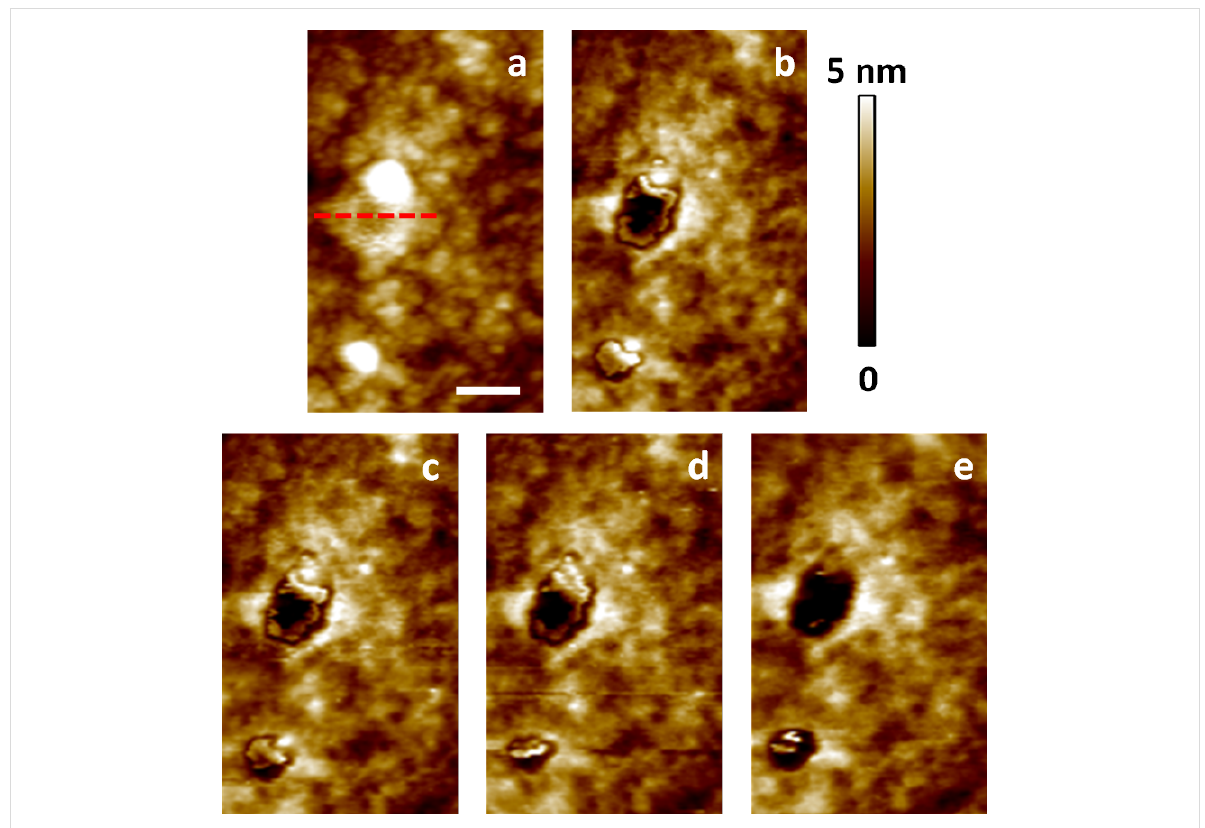
Figure 6: Morphology change of the topographical feature highlighted in Figure 1a for different imaging conditions. (a) and (b) show results taken from the images shown in Figure 1a and 1c, respectively. The panels (c–e) show results acquired during the three experiments shown in Figure 3 with increasing indentation (from the top row to the bottom row in Figure 3). This behavior is initially reversible but becomes irreversible after repeated imaging under highly repulsive conditions. The scan line profiles along the dashed red line for (a), (b), (c) and (e) are provided in Figure 7. The scale bar is 50